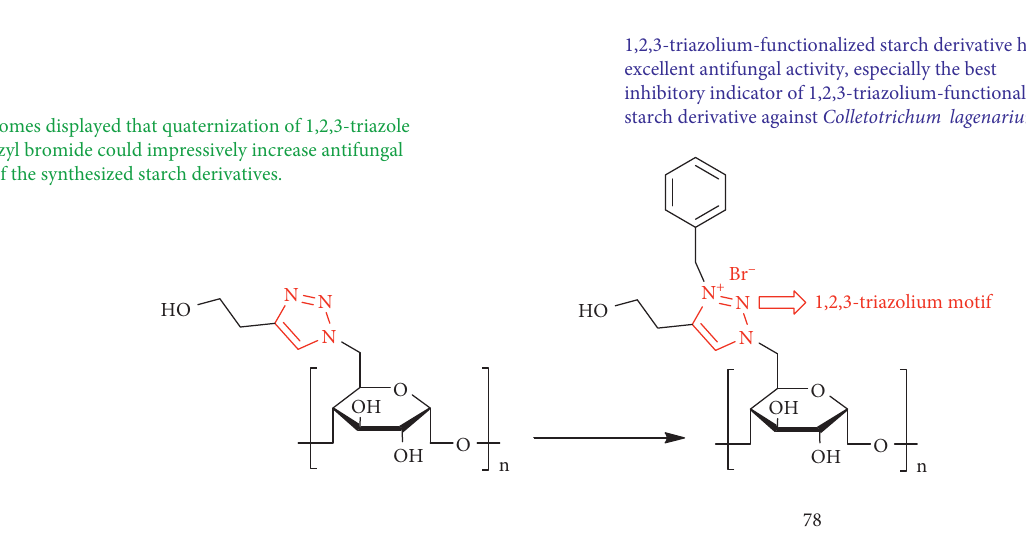
Figure 30: Chemical structure of novel 1,2,3-triazolium-functionalized starch